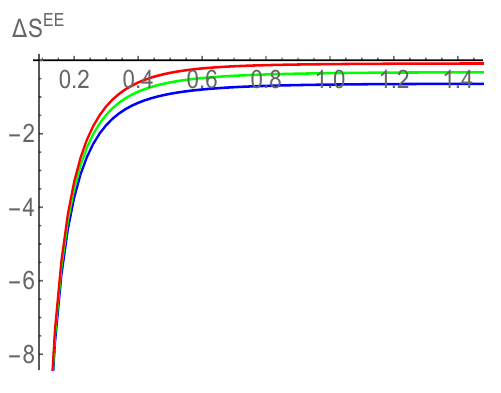
Figure 15 . (cid:1) S EE = S EE (cid:0) S EE as a func- con discon tion of ‘ in the decon(cid:12)nement phase. Here (cid:22) = 0 and red, green and blue curves correspond to T=T c = 1 : 2, 1 : 6 and 2 : 0 respectively. In units